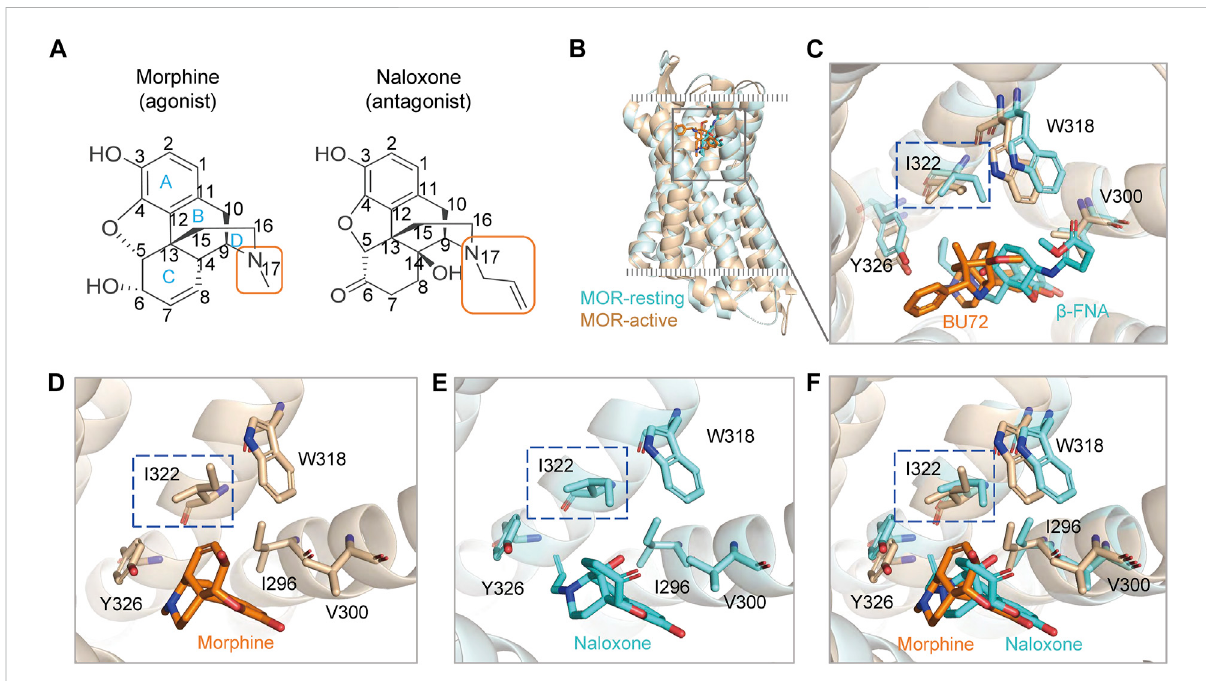
Agonists and antagonists with similar chemical backbones have the same binding pocket in the μ -opioid receptor (MOR). (A) chemical structures of morphine and naloxone. Carbon atoms of both compounds are labeled with numbers. (B) superimposed structures of rat MOR (rMOR) in the activated (light brown) and inactivated (cyan) states. (C) zoom in view of the binding models of BU72 and β -FNA to MOR with reference to the resolved crystal structures. (D – F) binding modes of morphine (D) and naloxone (E) to MOR by using induced fi t docking (IFD). The merged model is shown in panel (F) . The different conformations of residues I322 in the IFD model for morphine and naloxone are highlighted by the blue dashed